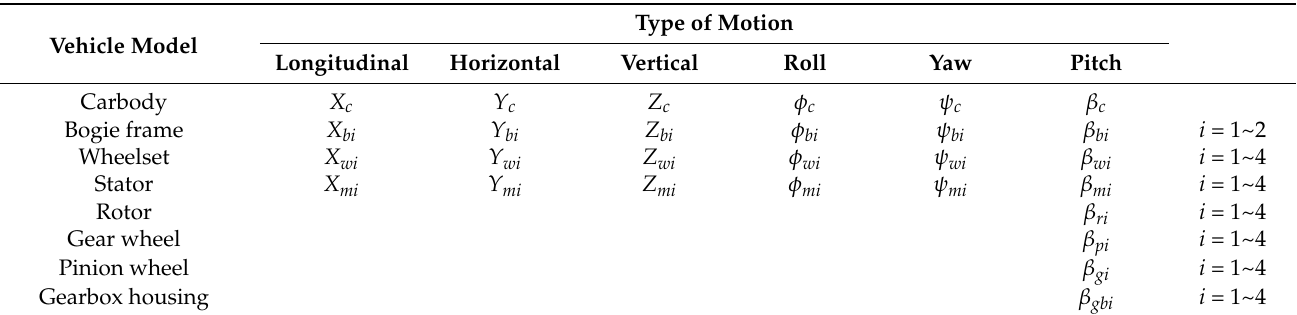
Table 1. Degrees of freedom for the railway vehicle.